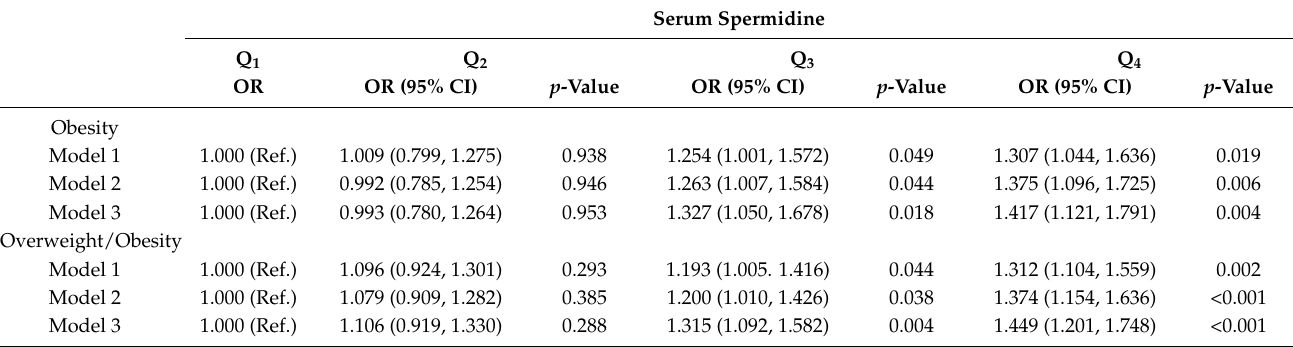
Table 2. OR and 95%CIs of serum spermidine levels for obesity (BMI ≥ 28 kg/m 2 ) and over- weight/obesity (BMI ≥ 24 kg/m 2 ) in the cross-sectional study. Serum